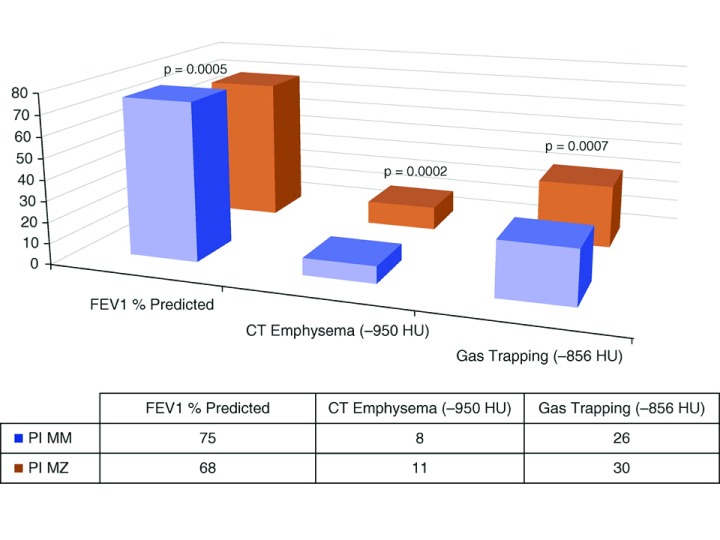
Lung function and chest CT imaging in PI MZ subjects in the COPD Gene Study.Non-Hispanic white subjects with PI MZ genotype had lower lung function and more emphysema and gas trapping on quantitative analysis of chest CT scans. FEV1 = forced expiratory volume in 1 second. HU = Hounsfield units. Reprinted from
7 with permission of the American Thoracic Society. Copyright © 2017 American Thoracic Society.
Annals of the American Thoracic Society is an official journal of the American Thoracic Society.